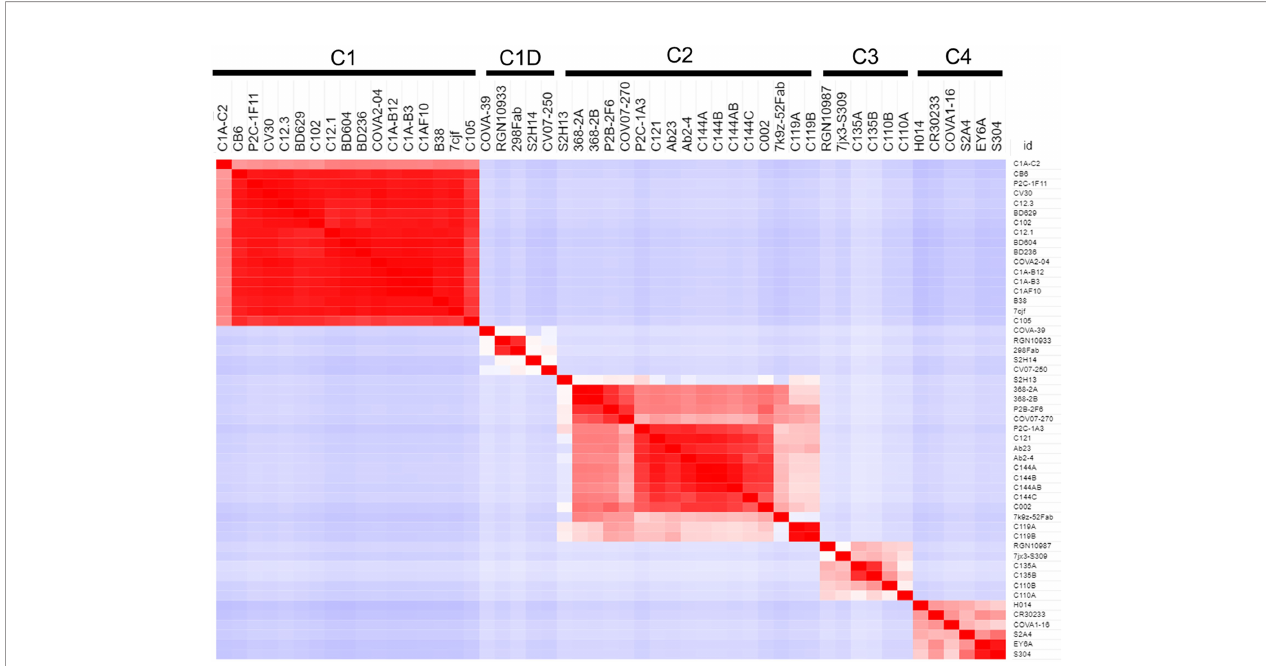
FIGURE 3 | Binding Pro fi le (BP) correlations to de fi ne RBD-binding NAb classes. BPs were de fi ned for NAb/RBD complexes ( Table 1 ) that were extracted from the pdb (n=45). For some structures, more than one NAb-RBD complex was evaluated leading to the A, B, C designations for some NAbs. Buried surface area was not calculated for some complexes, due to almost complete lack of sidechains for the NAbs. The BPs were subjected to hierarchical clustering and then similarity analysis (correlation coef fi cient calculation) to de fi ne fi ve NAb classes C1 (n=17), C1D (n=5), C2 (n=12), C3 (n=4), and C4